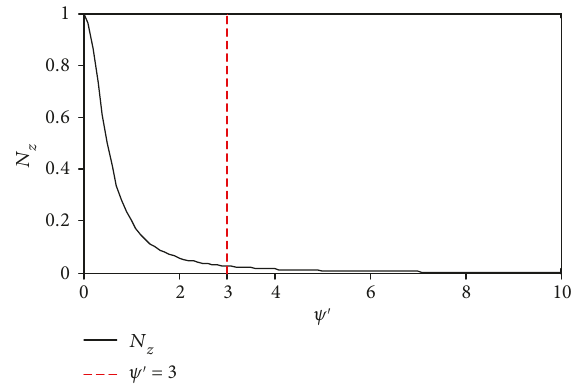
ψ ′ of the conical z and